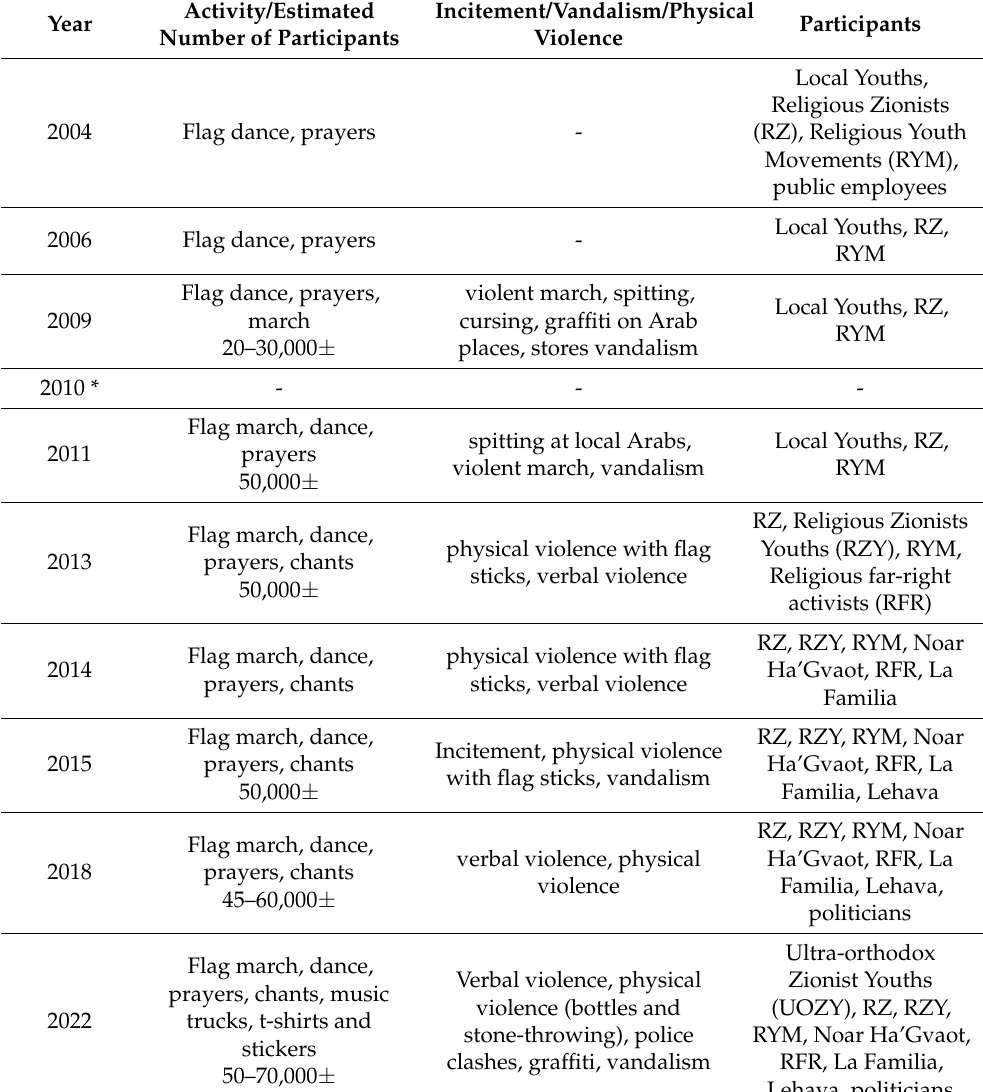
Table 2. Radicalisation in the flag